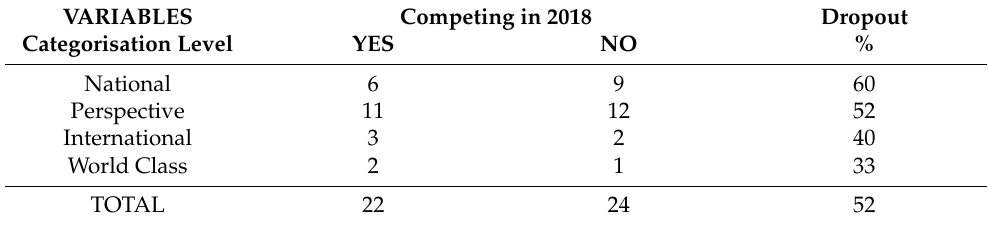
Table 2. Dropout of athletes in 10 years.